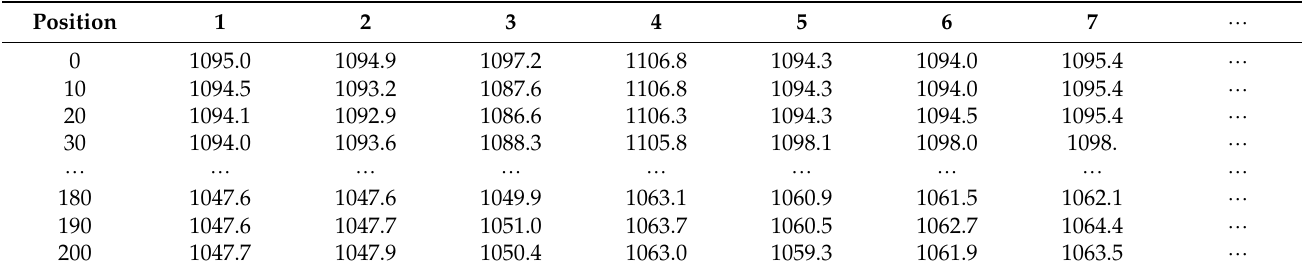
Table 7. Sample database of final cast blasting stockpile profile